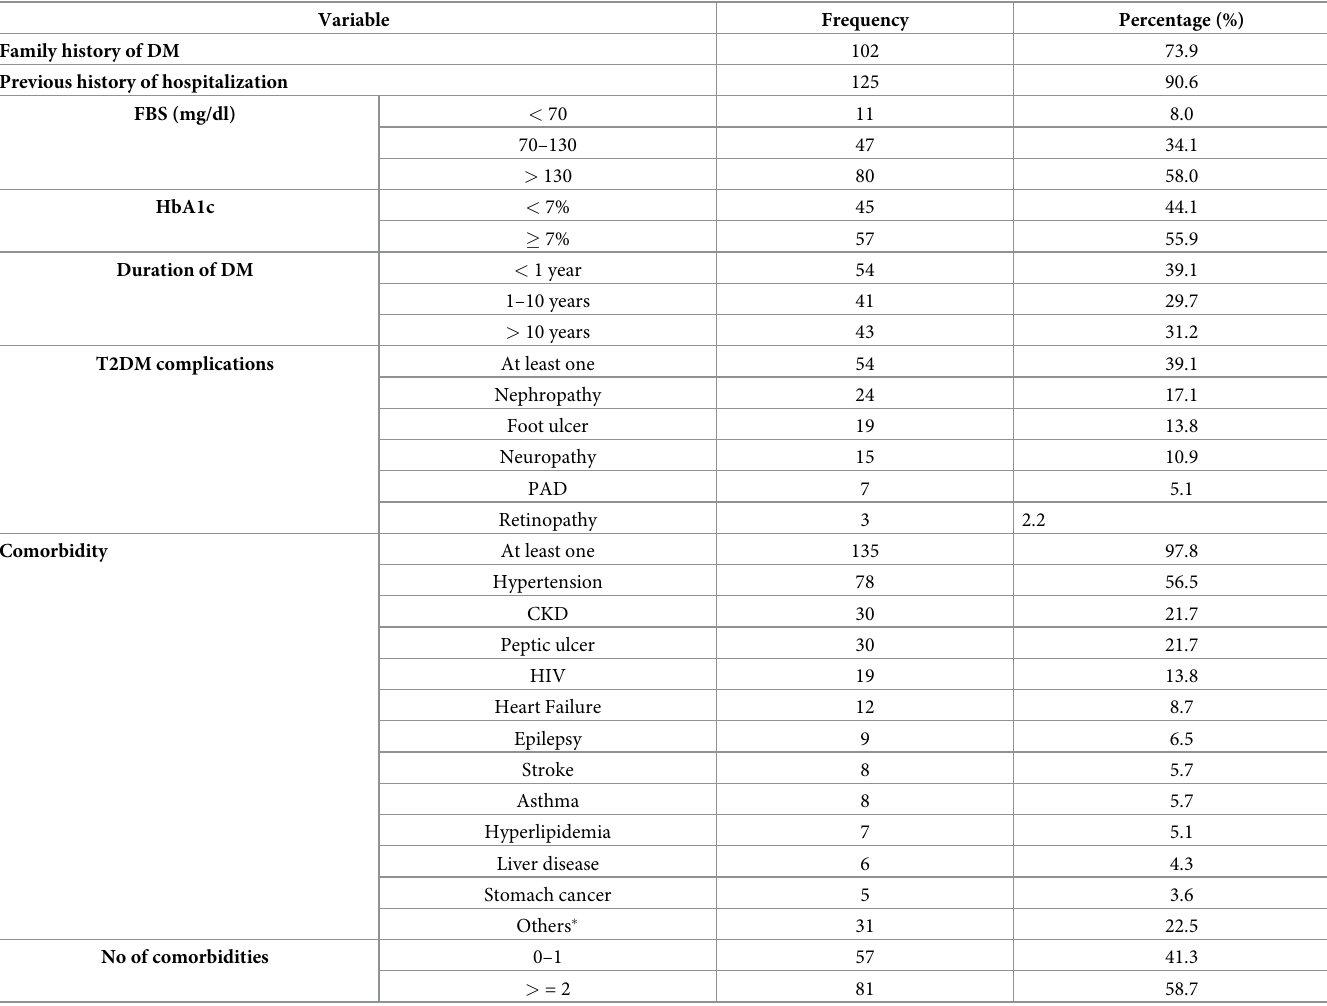
Table 2. Disease related factors among T2DM patients at medical and surgical wards of MRRH from November 2021 to January 2022, Mbarara,